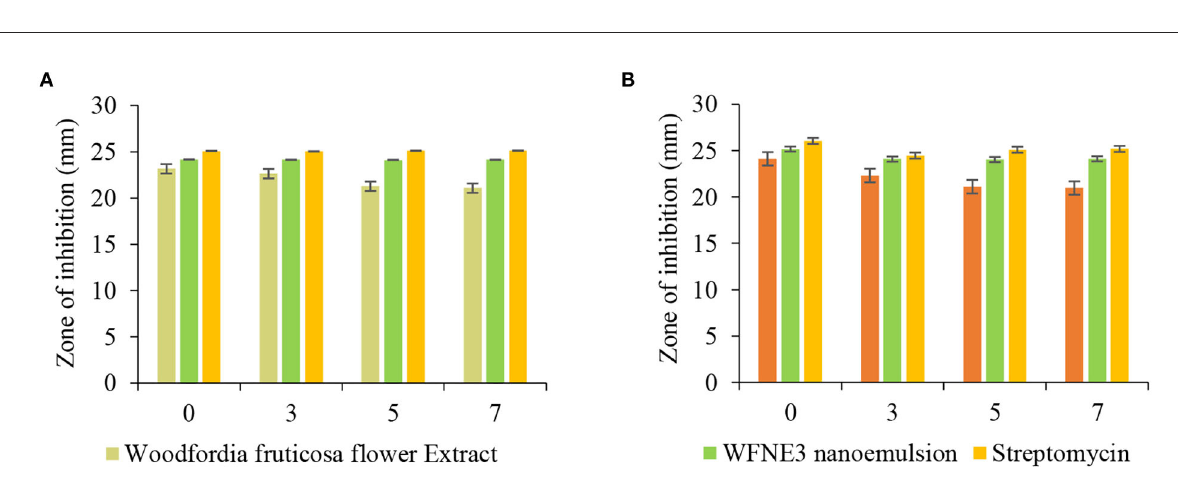
FIGURE5 Effect of storage on the antimicrobial efficacy of WFNE3 nanoemulsion against ( A) Pseudomonas aeruginosa and Staphylococcus aureus; and ( B) Candida albicans. The error bar represents the standard deviation from the mean